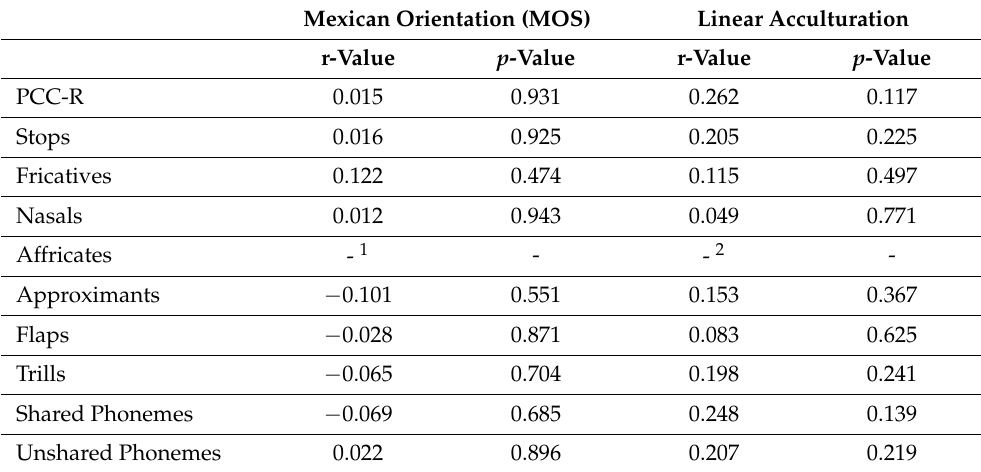
Table 5. Bivariate correlations between maternal Mexican orientation (MOS) scores and linear acculturation scores and children’s Spanish phonological accuracy